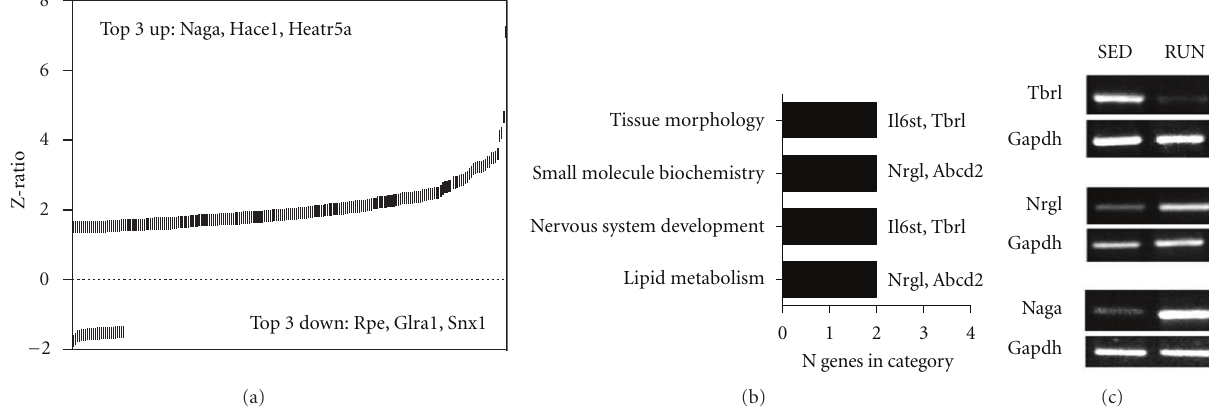
Figure 6: db/db mice respond to running with a distinct transcriptional profile. (a) Leptin receptor-deficient db/db mice exhibit transcriptional upregulation, indicated by positive Z -ratios, following twelve weeks of voluntary wheel running. Rpe, ribulose-5-phosphate- 3-epimerase; Glra1, glycine receptor, alpha 1 subunit; Snx1, sorting nexin 1; Naga, N-acetyl galactosaminidase, alpha; Hace1, HECT domain and ankyrin repeat containing, E3 ubiquitin protein ligase 1; Heatr5a, HEAT repeat containing 5A. (b) Pathway analysis of genes regulated by voluntary exercise in db/db mice. Abbreviations: Il6st, interleukin 6 signal transducer; Tbr1, T-box brain gene 1; Nrg1, neuregulin 1; Abcd2, ATP-binding cassette, sub-family D, member 2. (c) PCR validation of di ff erences in gene expression following running in db/db